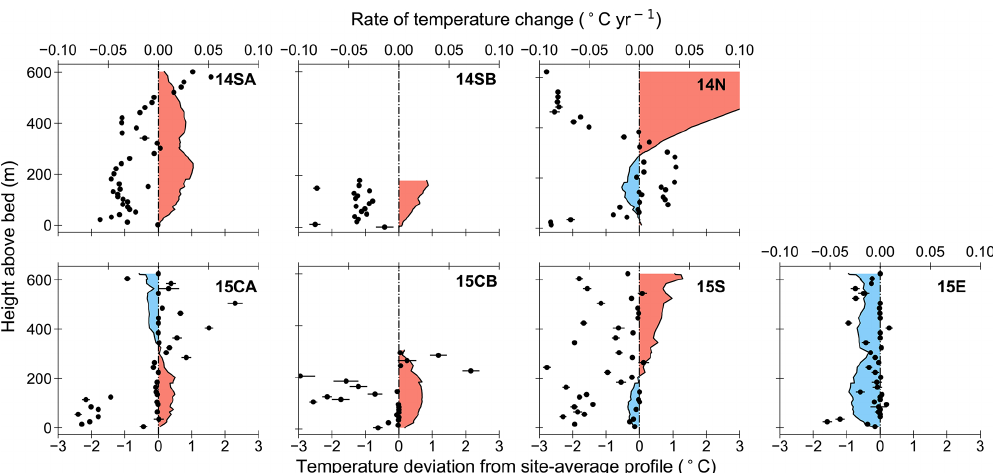
Figure 5. Rates of temperature change for each borehole (black dots) plotted with temperature deviations within each borehole from the site-average temperature profile. Red shaded regions indicate that the collected static profile is warmer than the site-average profile, and blue shaded regions show the static profile is colder than the site-average profile. Error bars on the calculated rates are the same as in Fig.